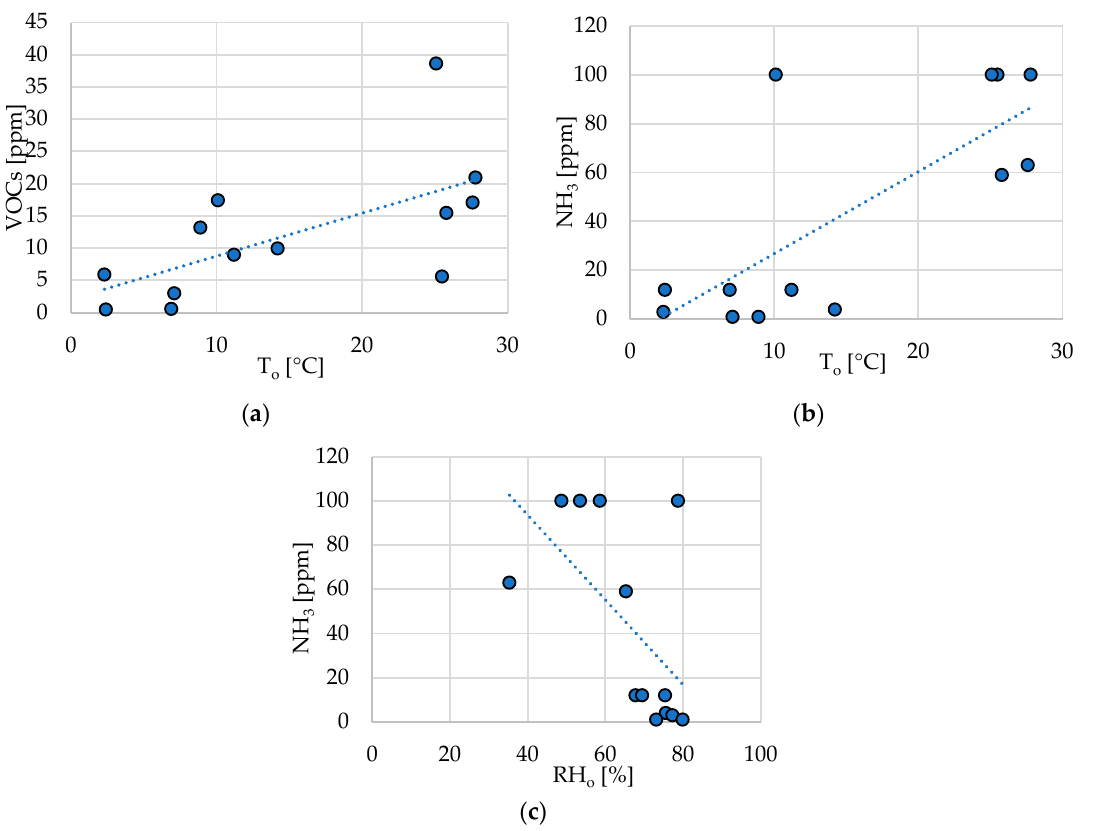
Figure 9. Correlation diagrams between odorant concentration in the oxygen stabilisation section of biogas plant B and measured microclimatic parameters, with regression lines: ( a ) R 2 = 0.40, ( b ) R 2 = 0.57, ( c ) R 2 = 0.35.